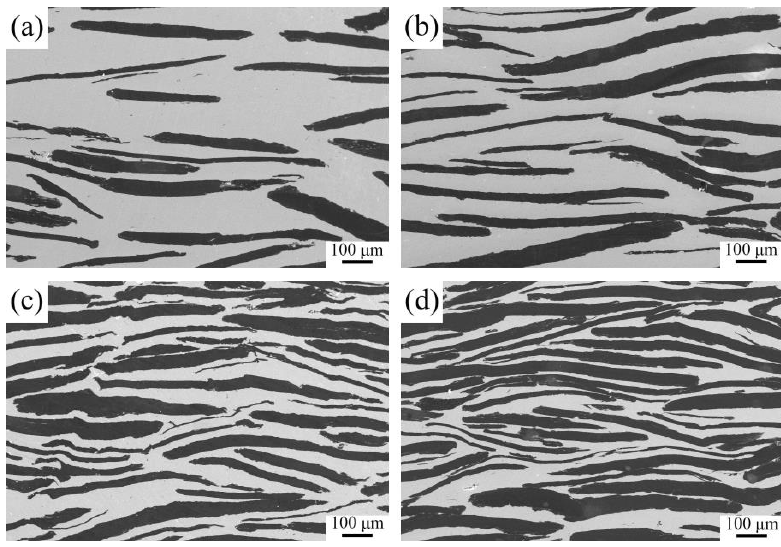
Figure 4. SEM images of TiC-coated graphite flake/Cu composites in Z direction: ( a ) 30 vol%, ( b ) 40 vol%, ( c ) 50 vol%, ( d ) 60 vol%.